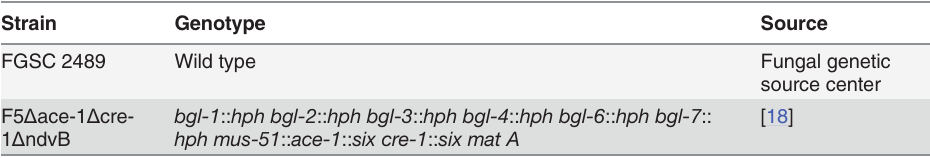
Table 1. Strains used in this